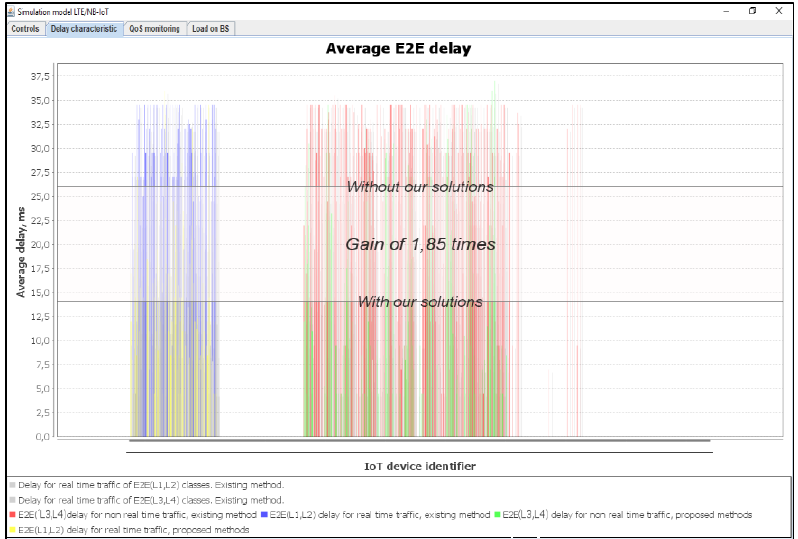
Figure 19. Average E2E delay gain of IoT services with our solution (average load of IoT controller ρ = 50%).